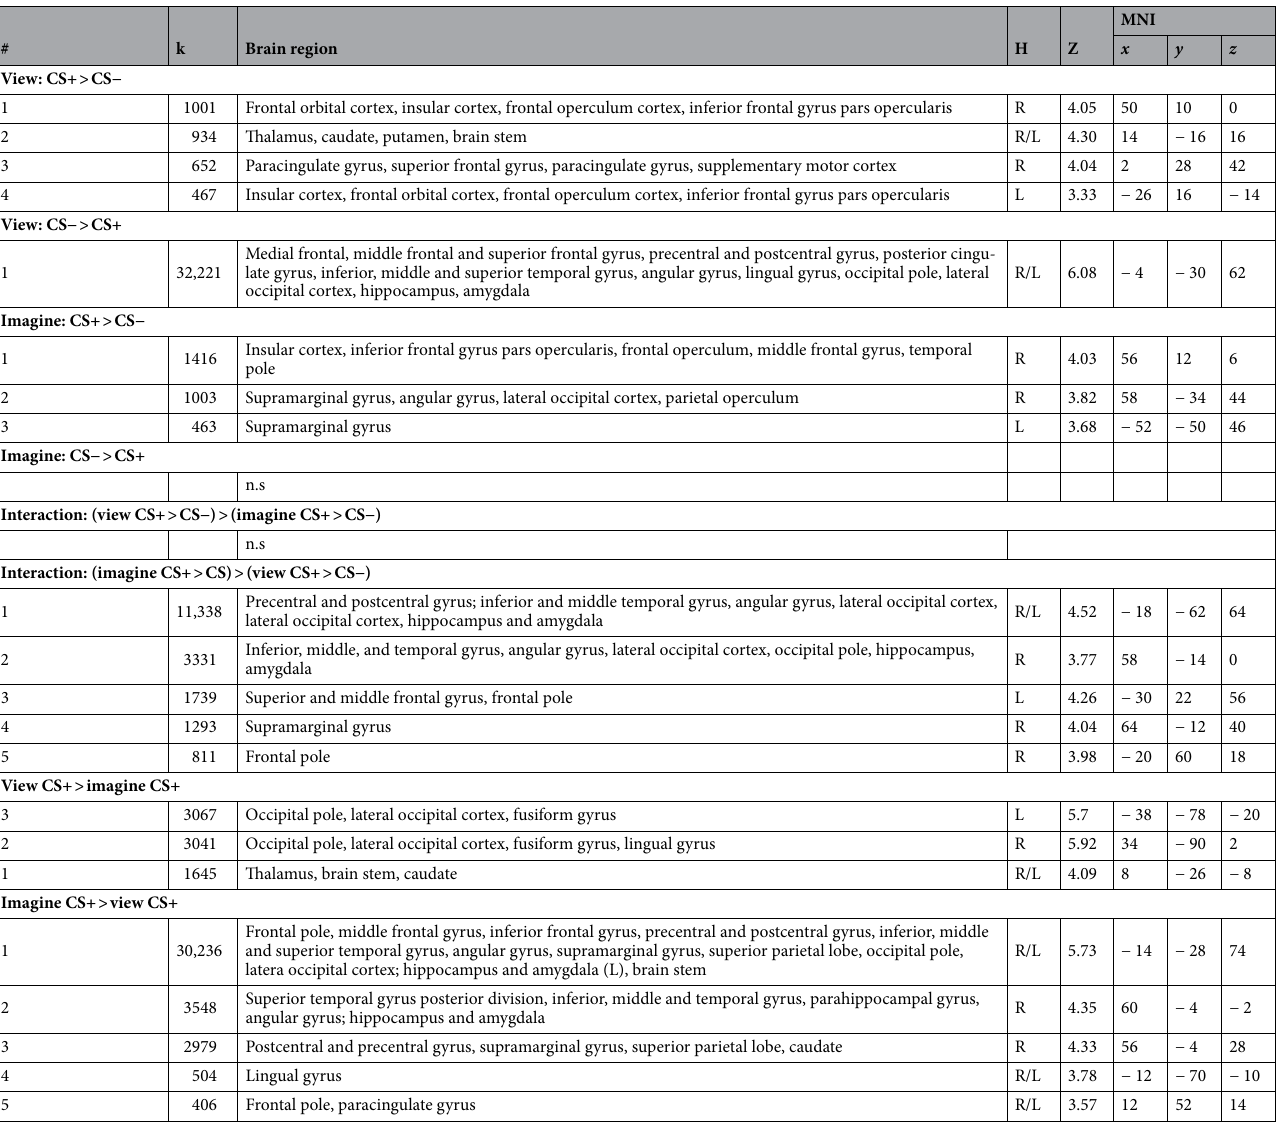
Table 1. Experiment 1 (Visit 1)—fear generalization to imagined stimuli. # = the number of a cluster, ordered by size; k = the number of contiguous voxels in the cluster; Brain region = regions of local maxima included in the broader cluster. The region names are taken generally from the Harvard–Oxford atlas in FSL; H = principal hemisphere of the cluster, right (R) or left (L); Z = maximum z-value from the cluster within the given brain region; MNI(X,Y,Z) = coordinates of the voxel with the maximum effect in the standardized space of the Montreal Neurological Institute (MNI), represented in units of millimeters (mm). All whole-brain unthresholded group-level maps can be viewed at neurovault.org (see